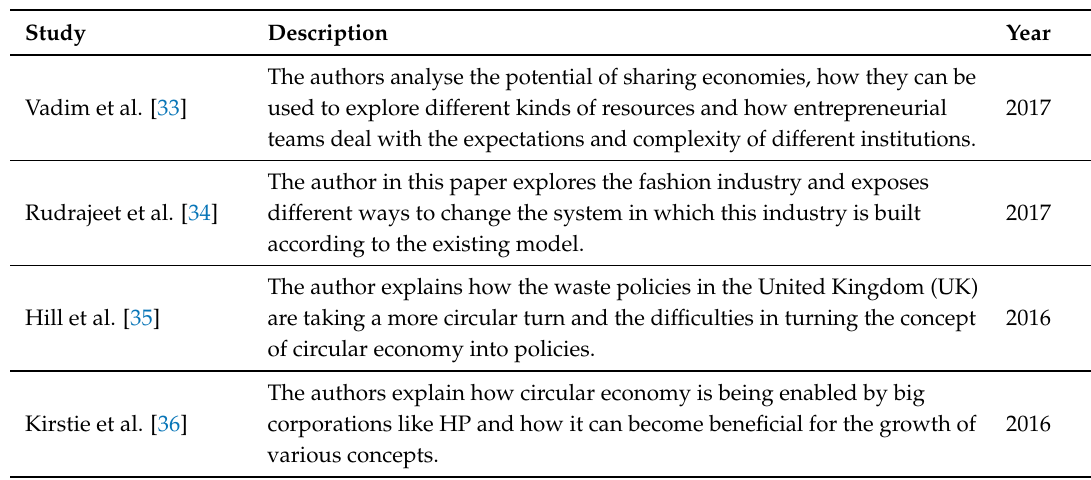
Table 2. List of studies